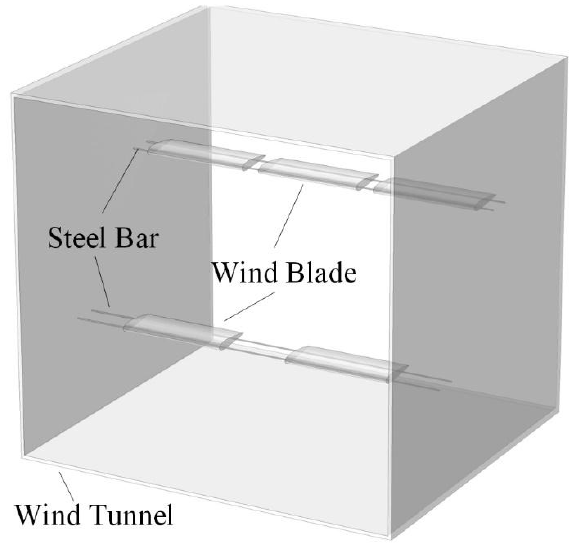
Figure 3. Arrangement of wind blade samples in the wind tunnel.